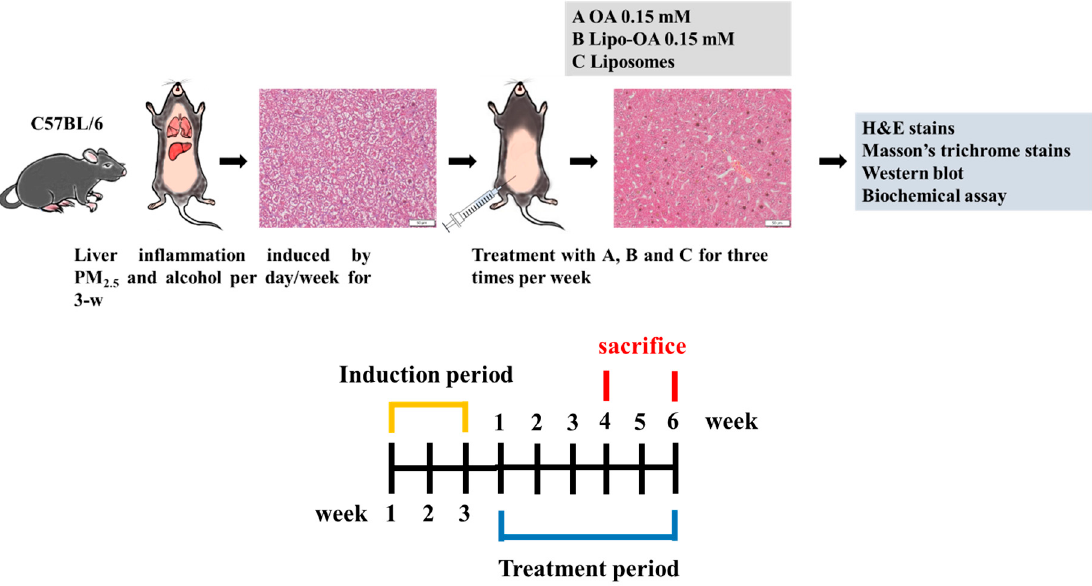
Figure 3. Schematic of PM 2.5 and alcohol-induced liver inflammation model and treatment proce ‐ dures.